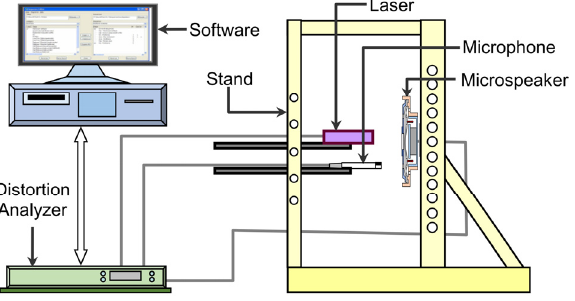
Figure 4. Schematic diagram of T/S parameter measurements of microspeaker using KLIPPEL measurement system.